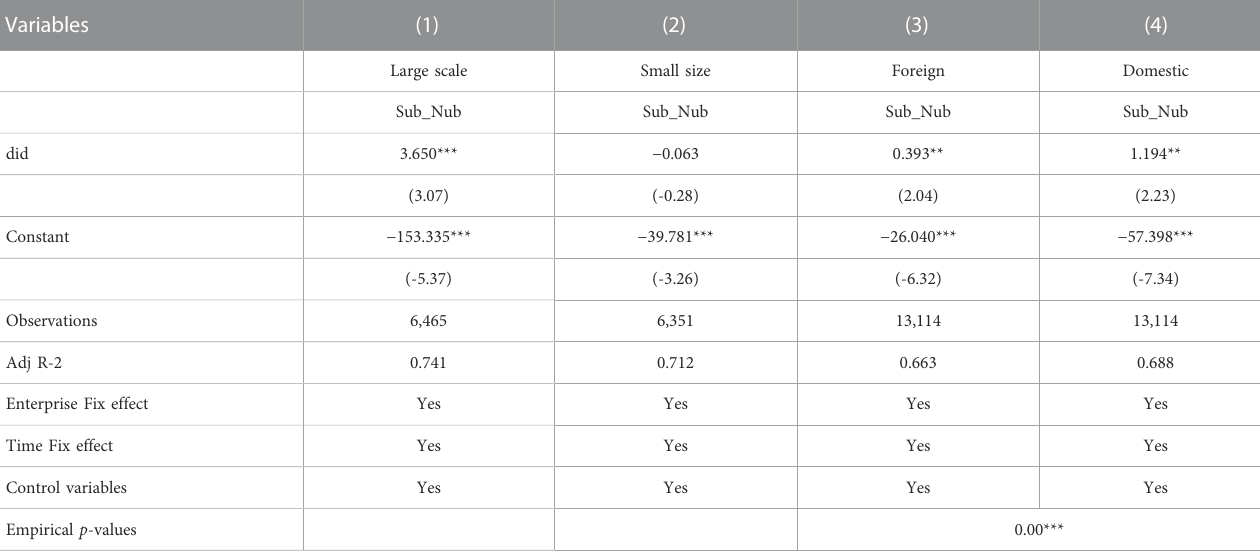
TABLE 7 Analysis of fi rm size response to policy.